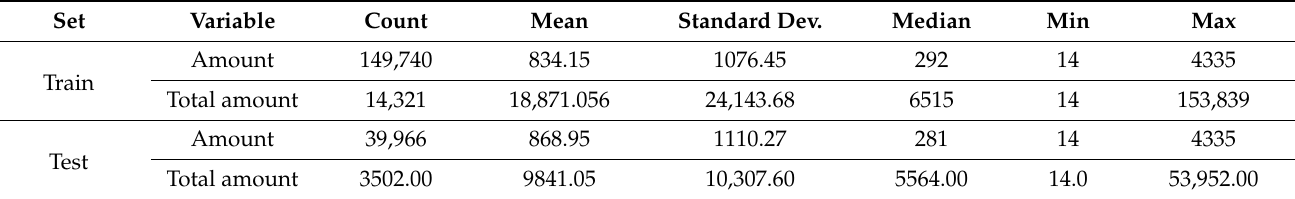
Table 3. Summary Statistics of Quantity of drugs consumed for a Train and test